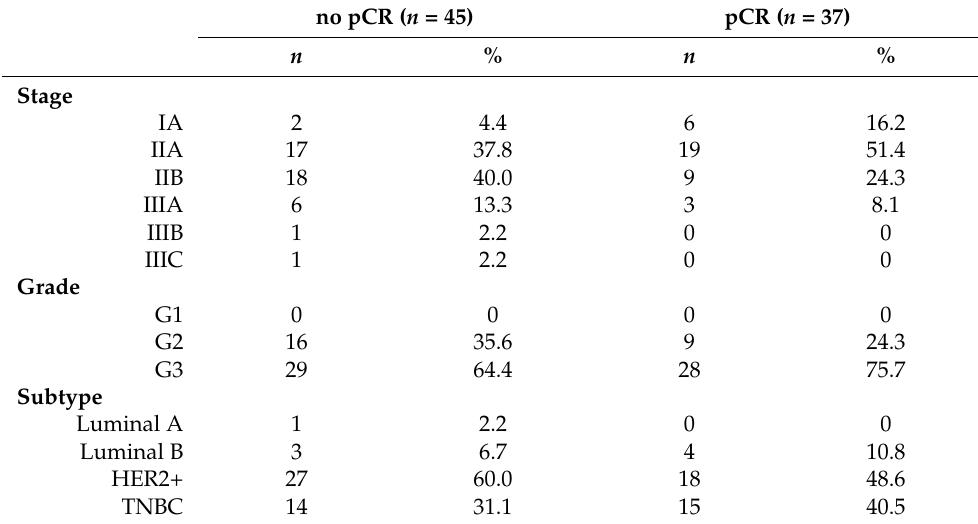
Table 2. Histopathological characteristics of BC ( n = 82).